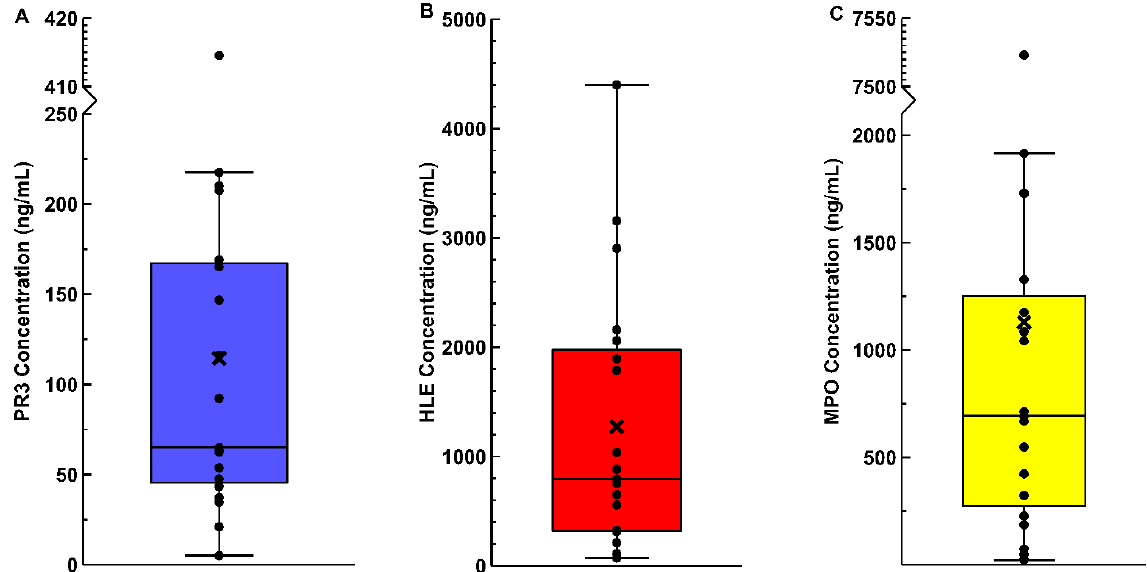
Figure 1. PMN enzyme synovial fluid concentrations. Samples were thawed on ice, diluted in their respective sample diluents, and their concentrations determined by ELISA. ( A ) Synovial fluid PR3 concentrations; ( B ) synovial fluid HLE concentrations; ( C ) synovial fluid MPO concentrations. Whiskers extend to points ≤1.5 × IQR, while means are represented by “×”.